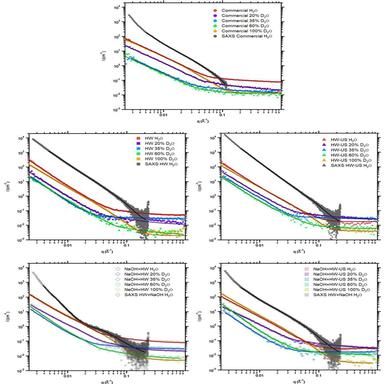
SAXS and SANS contrast variation data for the agar-based hydrogels. Dots represent the experimental data and solid lines show the fits obtained by applying the two-level unified model and simultaneously fitting the six data sets.